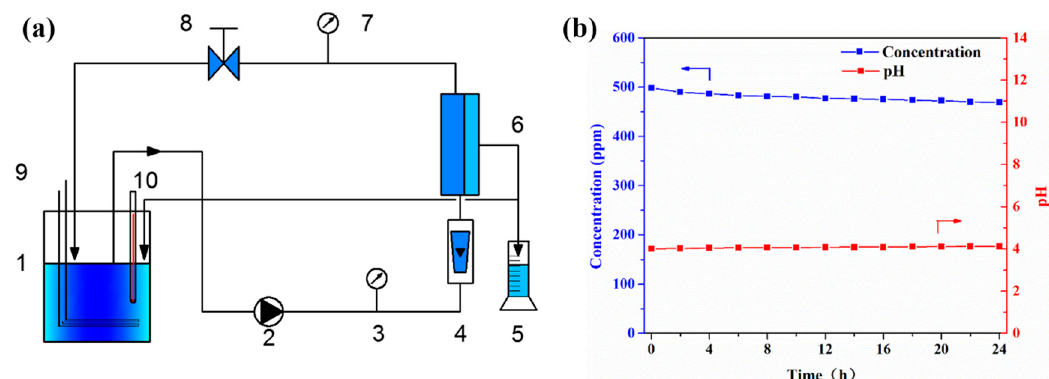
Figure 1. ( a ) Schematic diagram of crossflow membrane filtration equipment ((1) feed tank, (2) plunger pump, (3) pressure gauge, (4) rotameter, (5) volumetric cylinder, (6) membrane chamber, (7) pressure gauge, (8) flow valve, (9) water-cooled heat exchange tube, (10) digital thermometer); ( b ) the variations of concentration and pH of simulated secondary treated sewage (SSTS) in the feed tank during the 24-h filtration experiment.